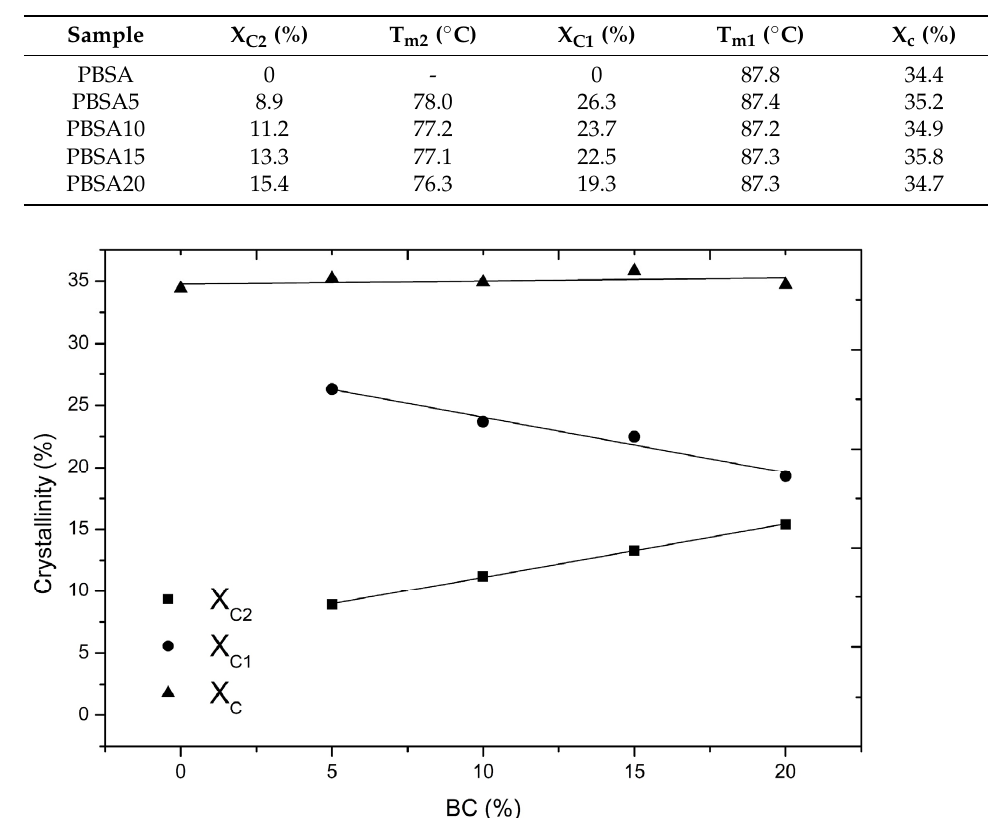
Figure 3. Crystallinity degree trend of PBSA and PBSA/BC